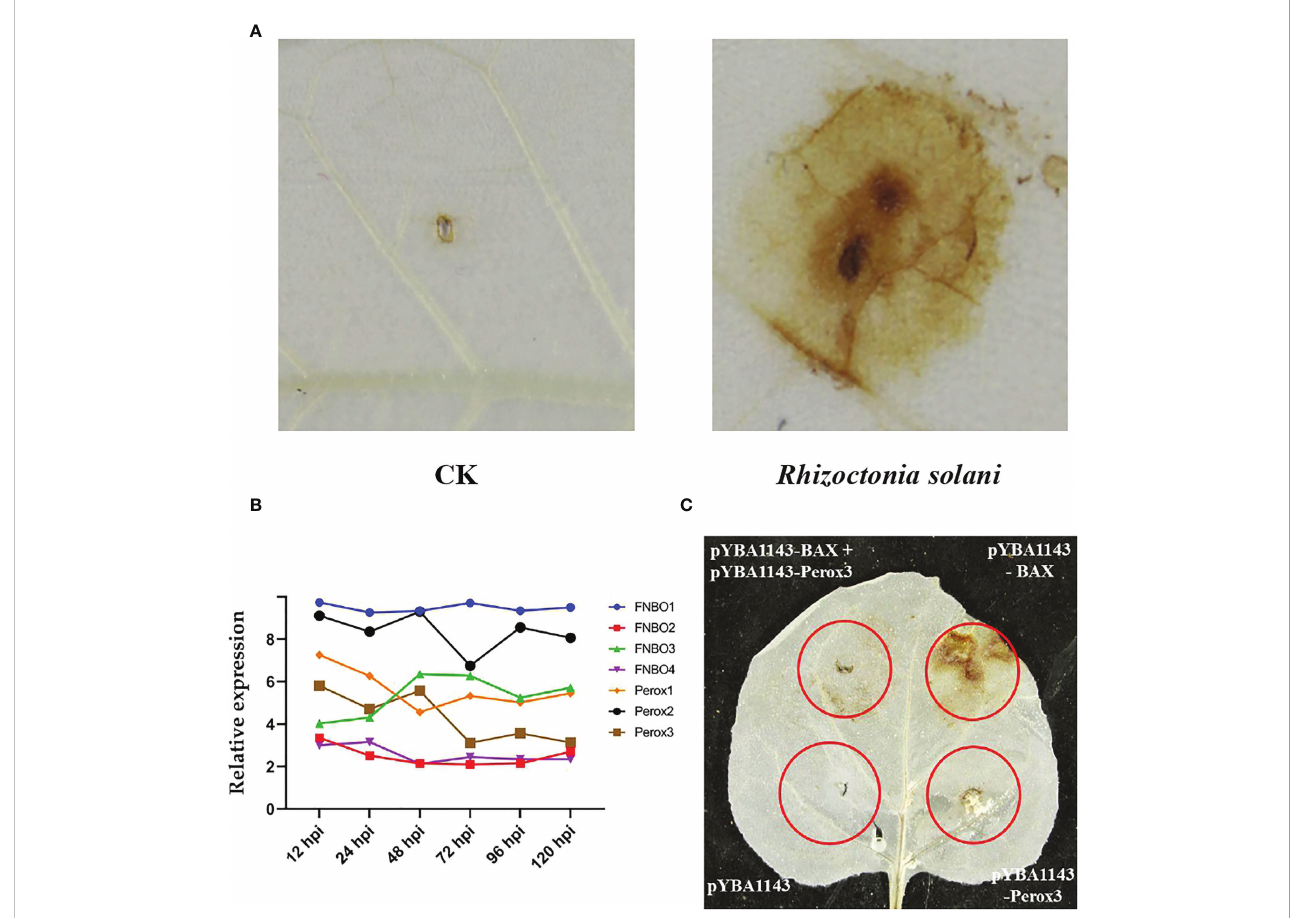
FIGURE 6 ROS production and scavenging. (A) Accumulation of ROS of tobacco plants after R. solani inoculation at 72 hpi. CK indicates non-inoculated plants. The yellow regions represent the the accumulated of ROS. (B) The expression of FNBO and Perox genes in R. solani . X-axis: 12 – 120 h: R. solani – inoculated tobacco harvested at various time points. Y-axis: Relative expression levels of select genes. (C) Analysis of ROS scavenging mediated by Perox3. pYBA1143: empty vector, pYBA1143-Perox3 and BAX: apoptosis regulator. The yellow regions represent the accumulated of